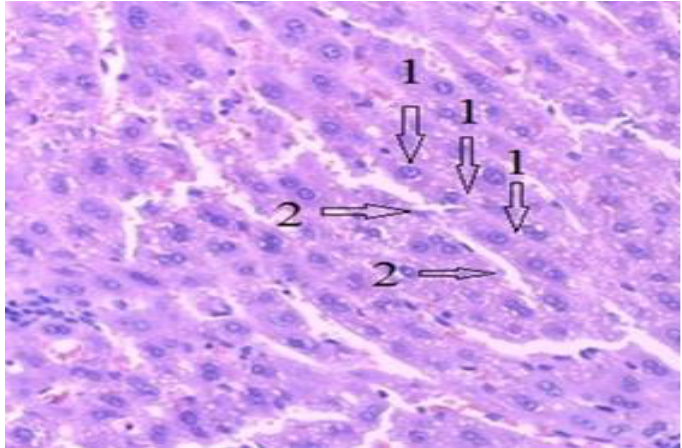
Figure 27. Liver tissue, H-E stain, 10 × 10. 1-Normal liver cells, 2-Normal aspect of bile ducts.